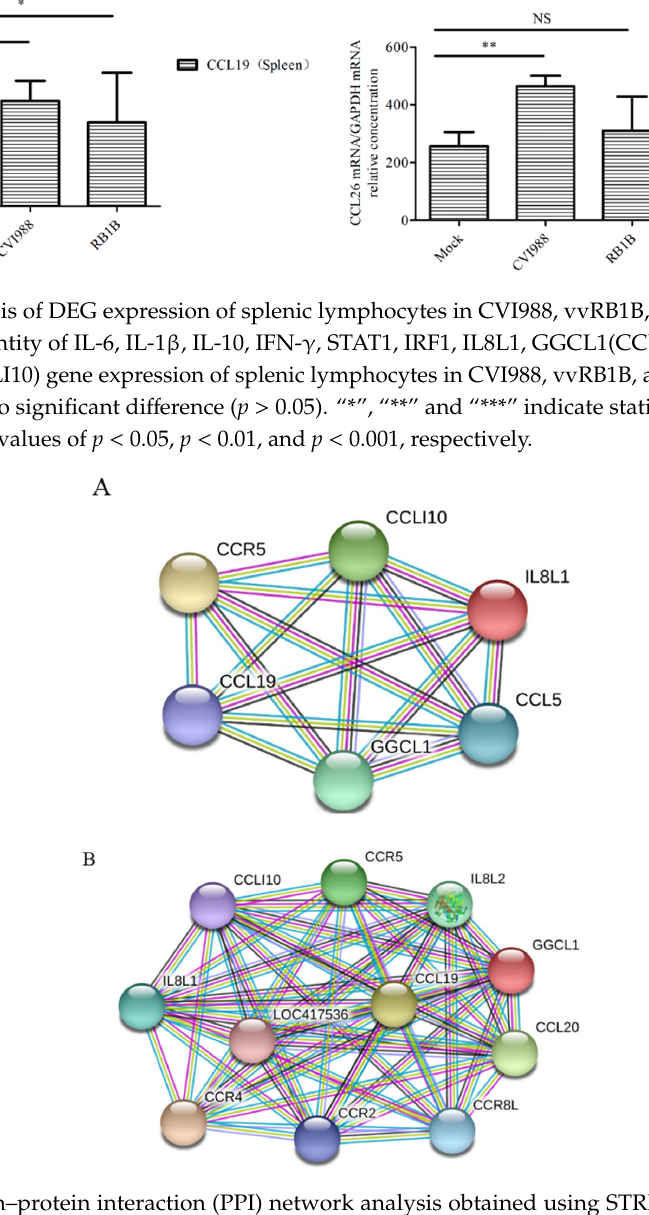
Figure 5. Protein–protein interaction (PPI) network analysis obtained using STRING. ( A ) Network representing genes that interact with CCL4 in response to MDV infection. ( B ) Genes currently known to interact with CCL4. Differently colored lines represent different types of evidence used in predicting interactions. Known interactions, light blue line: from curated databases; purple line: experimentally determined. Predicted interactions, green line: gene neighborhood; red line: gene fusion; blue line: gene co-occurrence. Others, yellow line: text mining; black line: co-expression; light purple line: protein